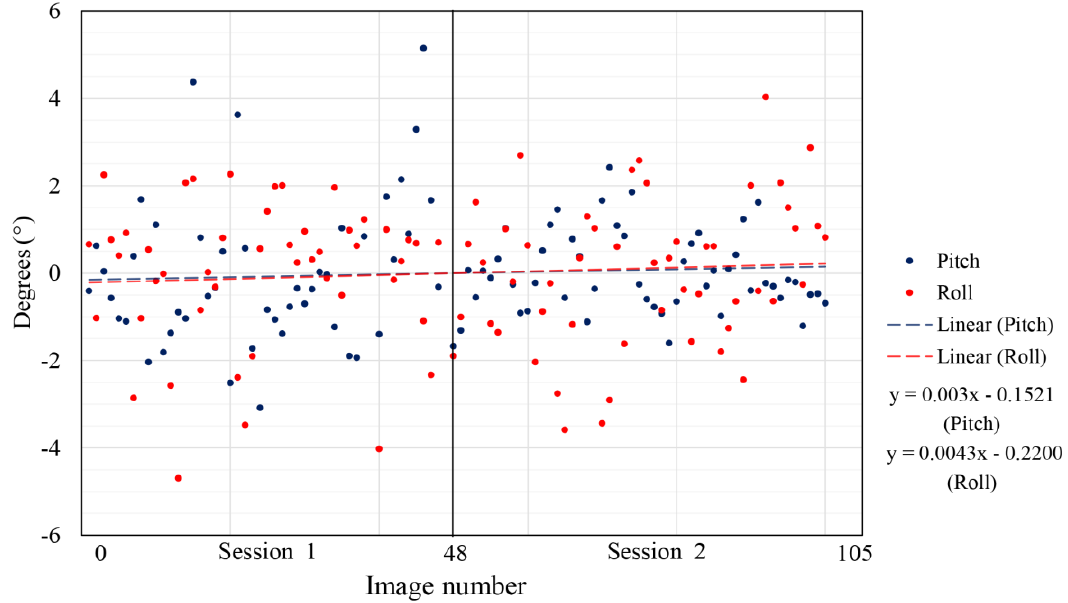
Figure 10. Roll and pitch parameter values and trend line for both sessions of outdoor flight.